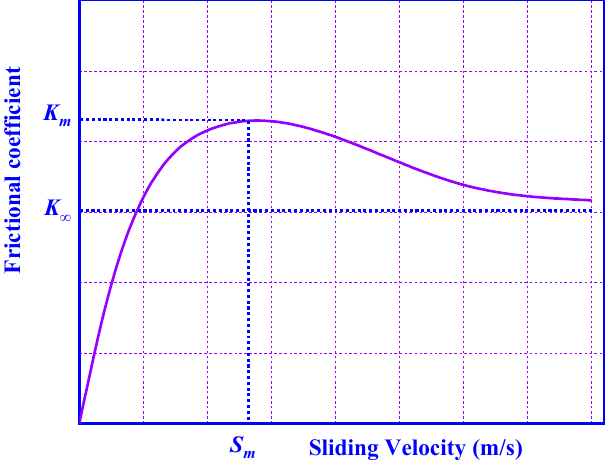
Figure 2. Change of frictional coefficient with sliding velocity [35]. The ball-disc test specimens are shown in Figure 3. The parameter values under different contact interfaces are shown in Table 1. Table 1. The values of S m , K m , K ∞ under different contact interfaces.